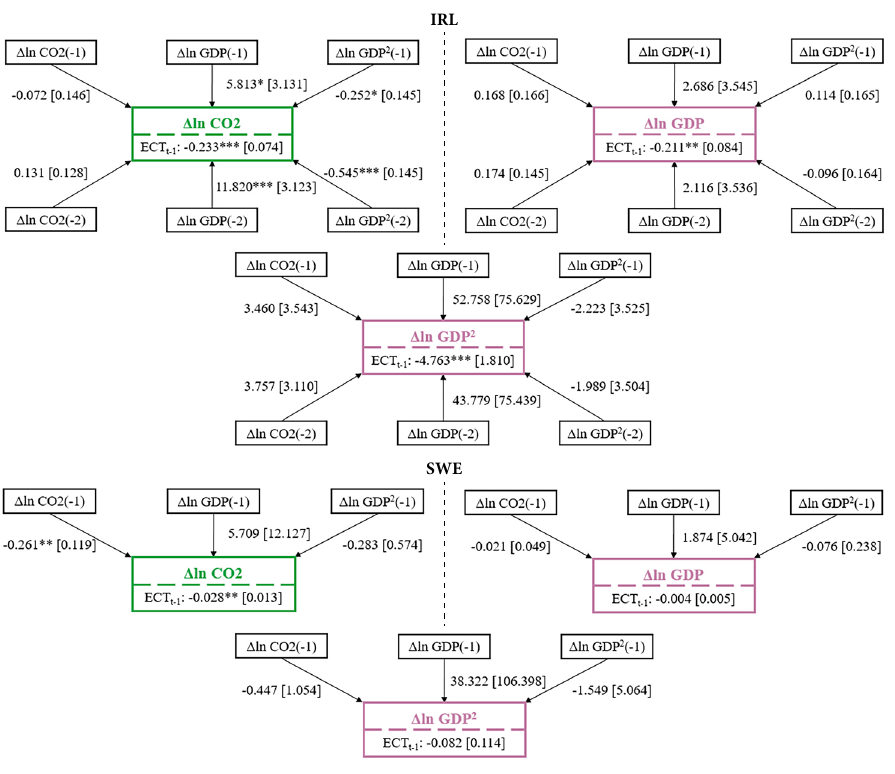
Figure 6. Granger causality test results – quadratic models